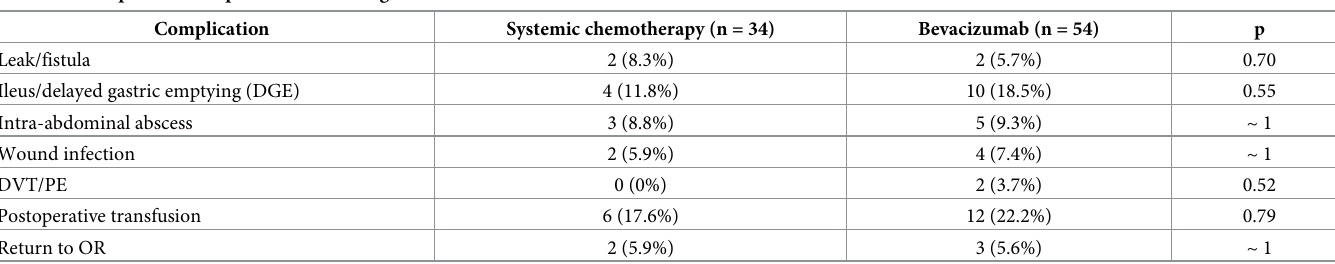
Table 3. Postoperative complications following CRS/HIPEC.